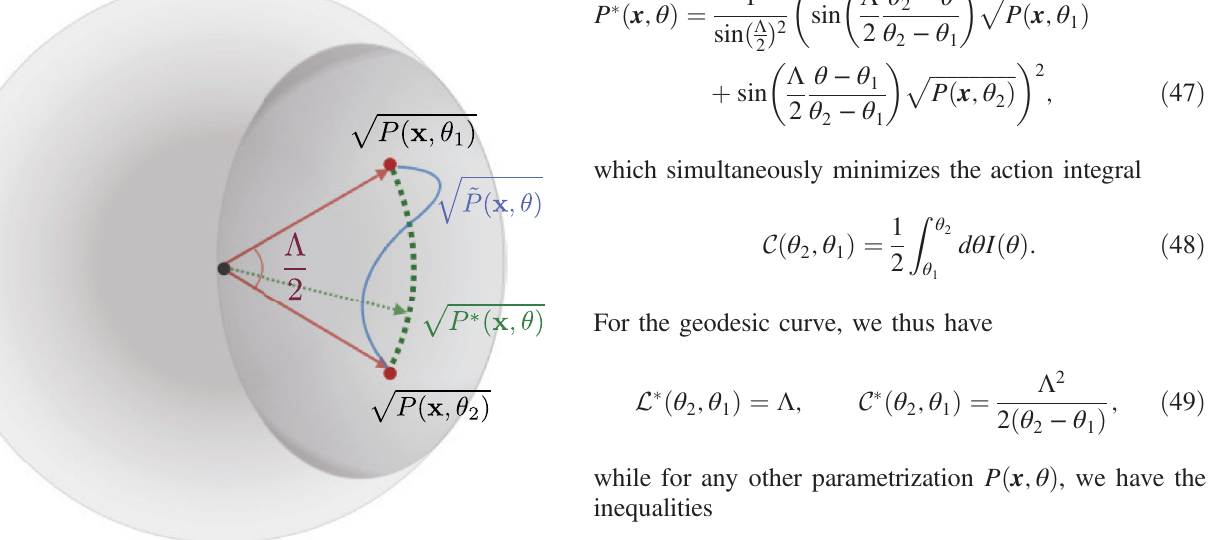
FIG. 1. Illustration of different parametrizations of the path between two probability densities P ð θ 1 Þ and P ð θ 2 Þ (red dots). ˜ P While any parametrization is constrained to lie on the unit sphere due to normalization, the length of the path can be arbitrarily long (blue). By contrast, the shortest possible path is given by the geodesic P (cid:3) (green dashed line). Note that this three- dimensional illustration corresponds to the case of three discrete states, whereas in the case of continuous random variables, the underlying space is infinite